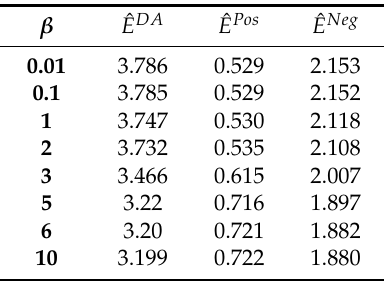
Table 1. Expected energy exchanged (MWh) for different values of β .